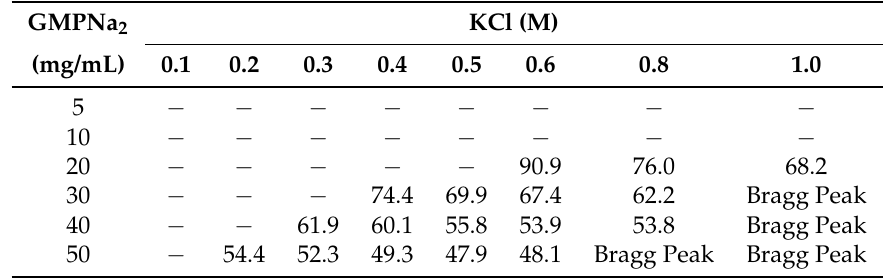
Table 3. Estimation of the length L (in Å) of G-quadruplexes occurring in GMPNa 2 samples prepared in KCl. Errors are of the order of 5%. Symbols as in Table